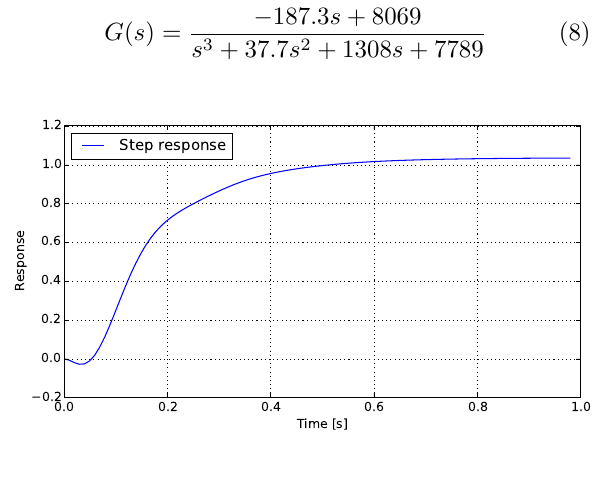
Figure 14: Step test response of a system with a right- half-plane zero.